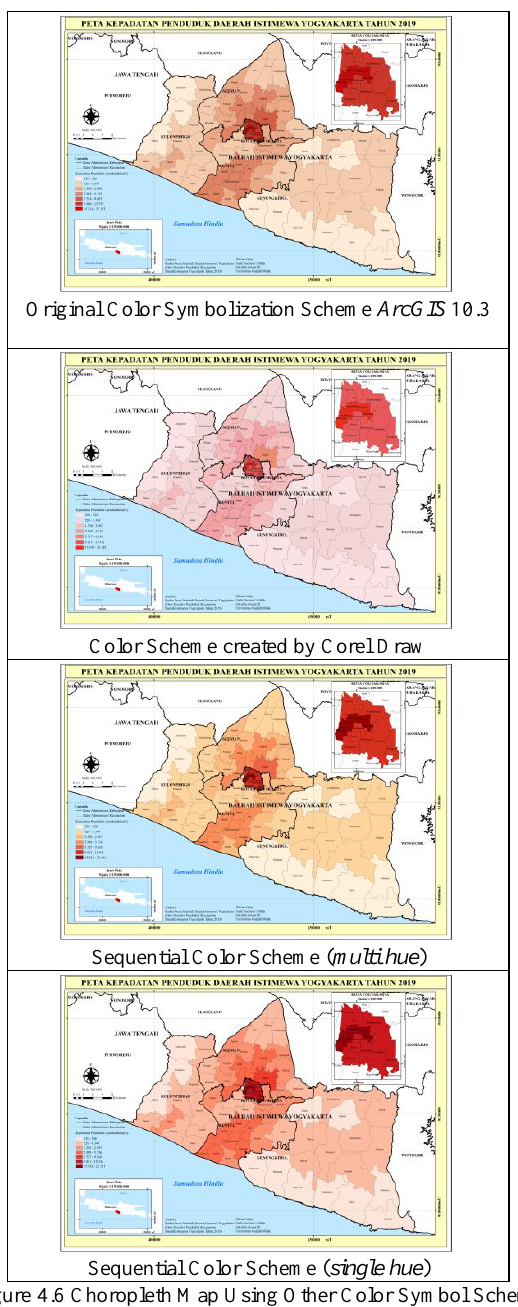
Figure 4.6 Choropleth Map Using Other Color Symbol